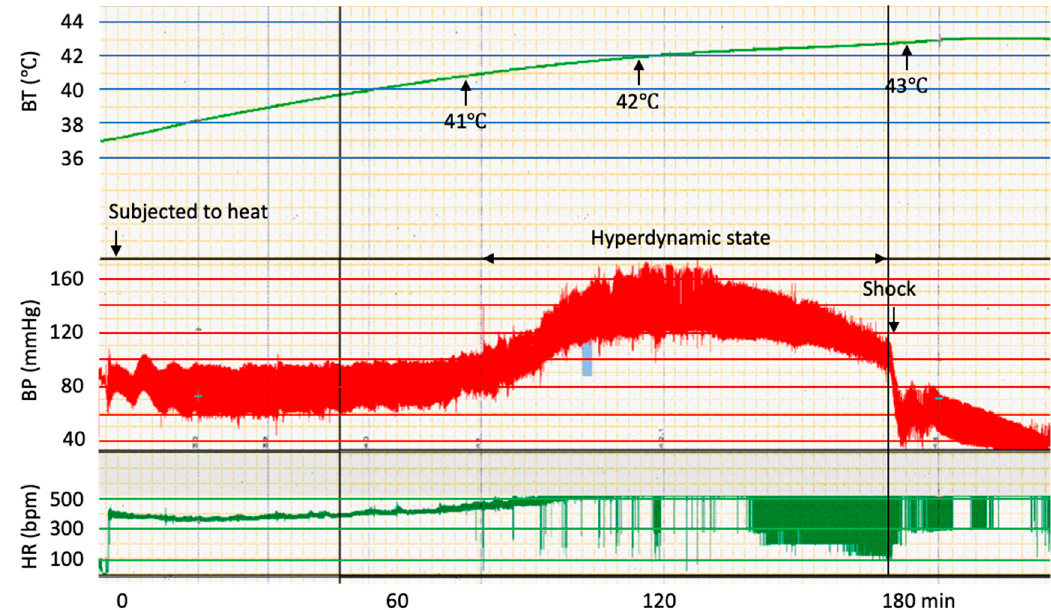
Figure 1. The typical time course of body temperature, blood pressure, and heart rate of a rat subjected to heat. With increasing body temperatures, first a high blood pressure was detected. Then, a hyperdynamic state continued until the body temperature reached 42.5 °C. Eventually, a sudden decrease in blood pressure was observed and animals went into shock when body temperatures approached 43 °C.